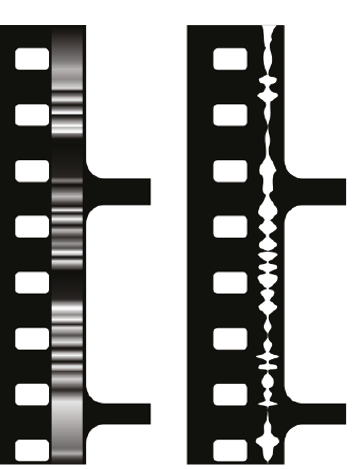
Figure 2: Left: variable density; right: variable area/fixed density.